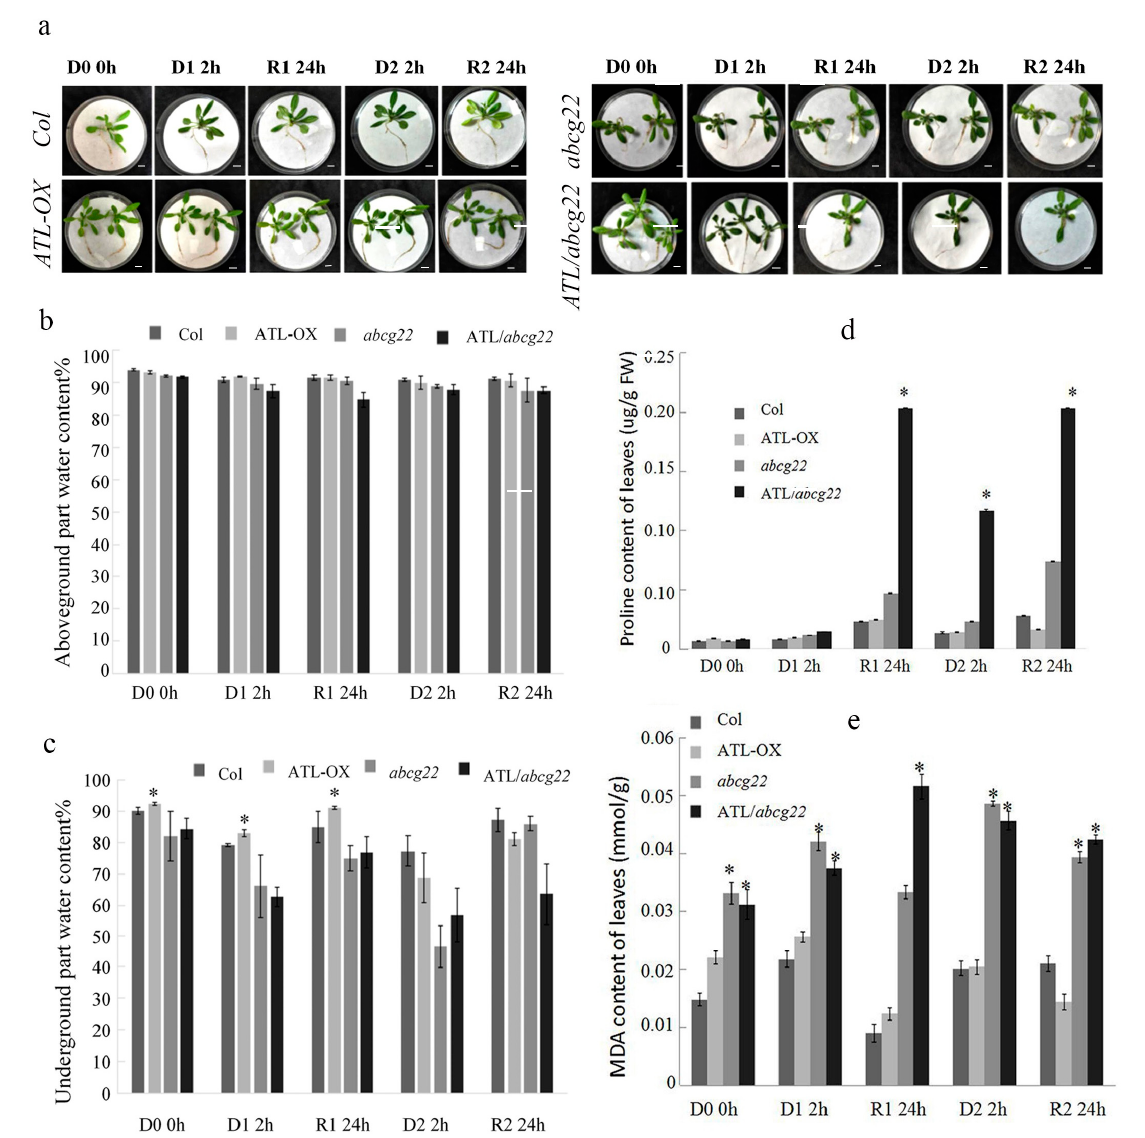
Figure 4. Overexpression of AhATL1 in Arabidopsis enhanced the plant tolerance during the drought stress memory process. ( a ) Drought tolerance phenotypes of four lines (Col, P35S::AhATL1-eGFP , atabcg22, and P35S::AhATL1-eGFP/atabcg22 ) that were dehydrated for 2 h and rehydrated for 24 h two times. ( b ) The aboveground water content of the four lines that were dehydrated for 2 h and rehydrated for 24 h two times. ( c ) The belowground water content of the four lines that were dehydrated for 2 h and rehydrated for 24 h two times. ( d ) The proline content of the four lines that were dehydrated for 2 h and rehydrated for 24 h two times. ( e ) The MDA content of the four lines that were dehydrated for 2 h and rehydrated for 24 h two times. All experiments, means, and SDs were obtained from more than three biological replicates. ‘*’ indicates a significant difference between AhATL1-OX, atabcg22 , P35S::AhATL1-eGFP/atabcg2 2, and Col plants under the same dehydration and rehydration treatment conditions ( p < 0.05). Asterisks in ( b ) to ( e ) indicate significant differences from Col in D1 0h (Student’s t test p values, * p <